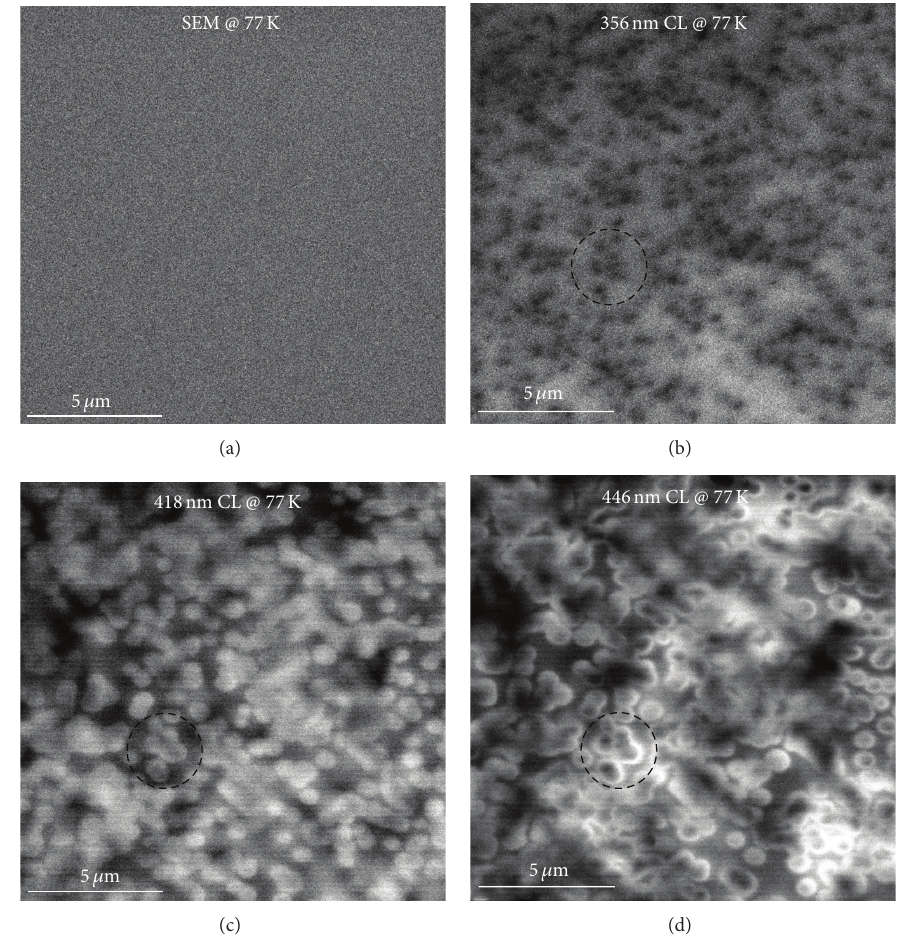
Figure 5: (a) SEM and ((b)–(d)) mono-CL images of the InGaN/GaN LEDs at low temperature. The CL images in ((b)–(d)) correspond to GaN, high-energy, and blue emission, respectively. The V-pits on the surface are not observed by the SEM measurements because of their shallow depth. Dark spots in (b) correspond to the dislocations in the LED structure. The dashed circles in (b)–(d) show competitions of the emissions around the